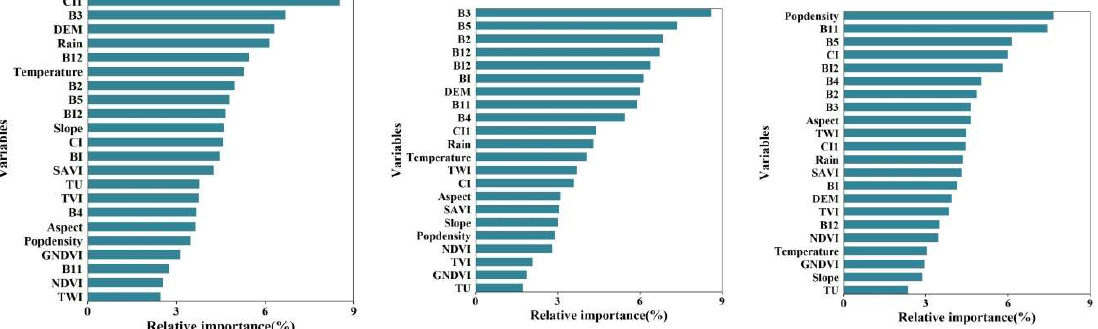
Figure 3. Comparison of the variables in terms of their relative importance using the RF model for the overall study area ( left ), forest area ( middle ) and farmland ( right ).